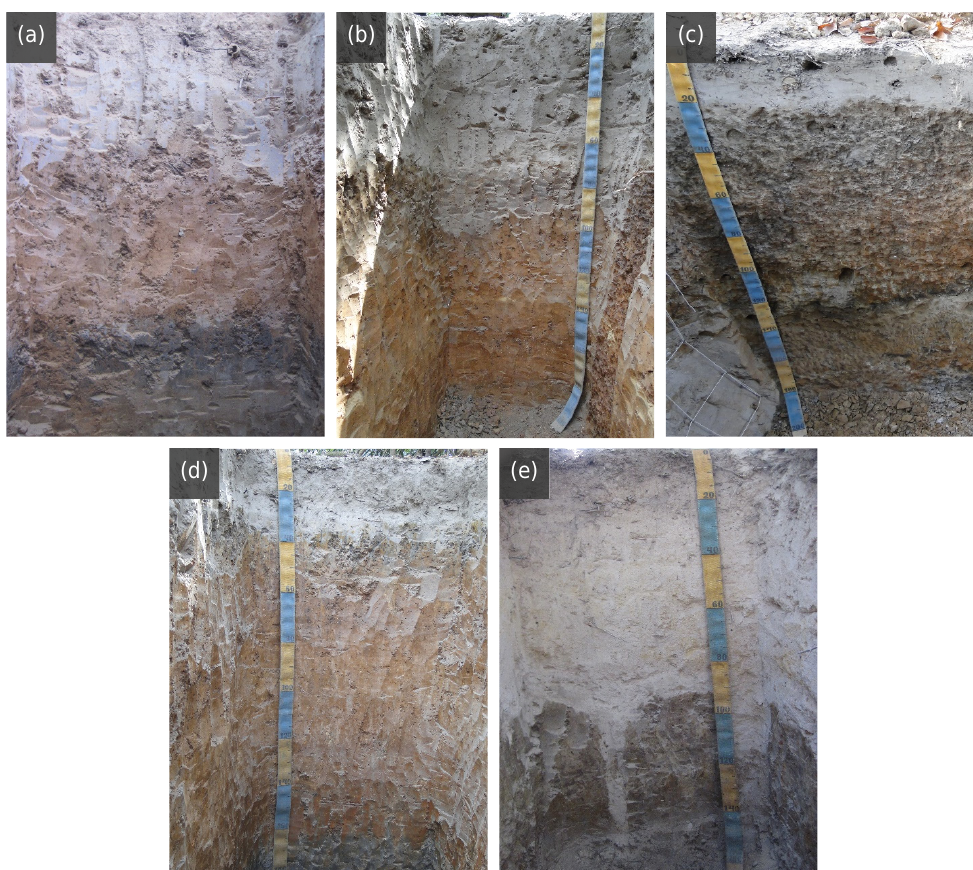
Figure 2. Soil profiles of points P1 (a), P2 (b), P3 (c), P4 (d), and P5 (e). All profiles had abrupt textural change, a B horizon with high chroma, with the exception of P5 which featured pale colors due to lower permeability, and a thicker E horizon entering the B horizon in “tongue”